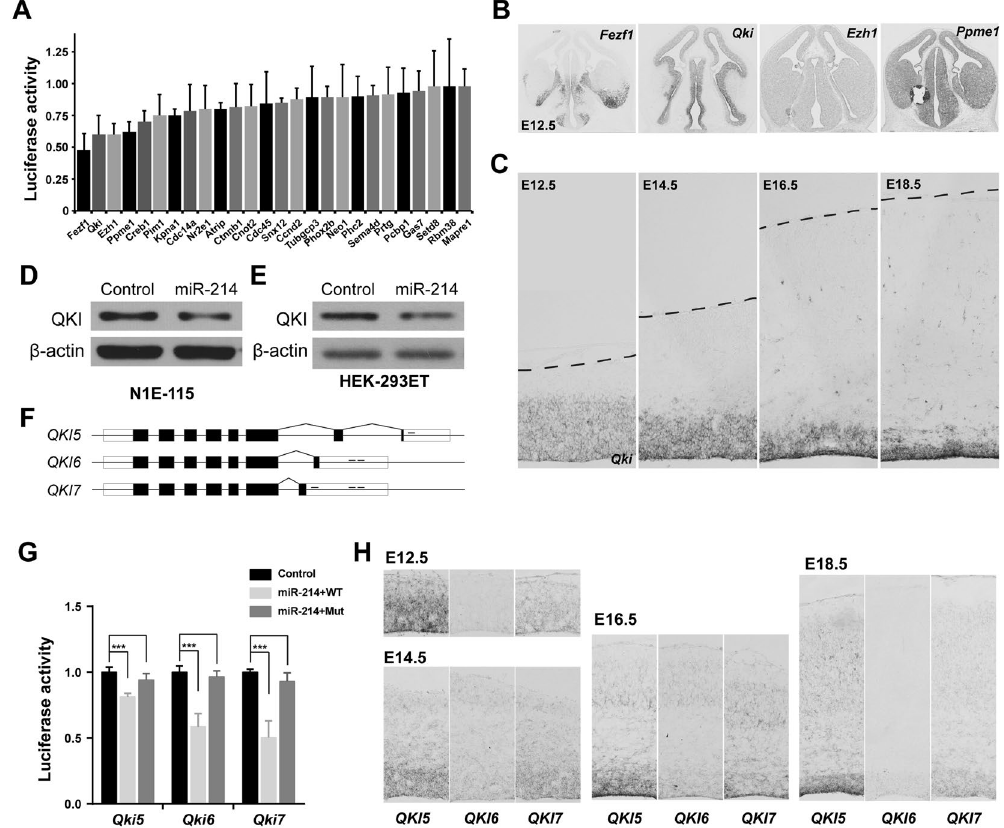
Figure 3. Qki is expressed in neural progenitor cells and targeted by miR-214. ( A ) Screening with 3 ′ UTR luciferase reporter assays to determine functional miR-214 binding sites. Bar graphs show the relative luciferase activity of 26 potential target gene 3 ′ -UTRs in HEK-293ET cells after overexpression of miR-214. Data were normalized to Renilla luciferase activity. ( B ) The mRNA expression of Fezf1 , Ezh1 , Qki and Ppme1 in the mouse telencephalon at E12.5, performed by in situ hybridization. ( C ) The dynamics of Qki mRNA expression during cerebral cortex development at E12.5, E14.5, E16.5 and E18.5. ( D , E ) Western blot analysis of QKI expression after overexpression of miR-214 for 48 hours in N1E-115 cells ( D ) and HEK-293ET cells ( E ). β -actin was included as a loading control. Uncropped versions of all western blots are shown in Supplementary Figure 3. ( F ) The structures of the three major alternative splice variants of Qki and the predicted miR-214 binding sites in their 3 ′ UTRs. The “ − ” sign over the black line represents the possible miR-214 binding sites. ( G ) Dual luciferase assays of 293ET cells co-transfected firefly luciferase construct containing the wild-type(WT) or respective target sites mutant(Mut) 3 ′ -UTR of the Qki isforms, along with the miR-214 expression plasmid or the empty vector. All experiments were normalized to co-transfected Renilla luciferase. Histograms show normalized mean values of the relative luciferase activity, from three or more independent transfections. Error bars show the standard deviation, and the comparisons were performed by Student’s t-test; the statistically significant P values are shown as * ( < 0.05), ** ( < 0.01) or *** ( < 0.001). ( H ) The in situ hybridization of the three Qki variants with specific probes respectively shows their expression pattern in the cerebral cortex at E12.5 to E18.5. Scale bar: 100 μ